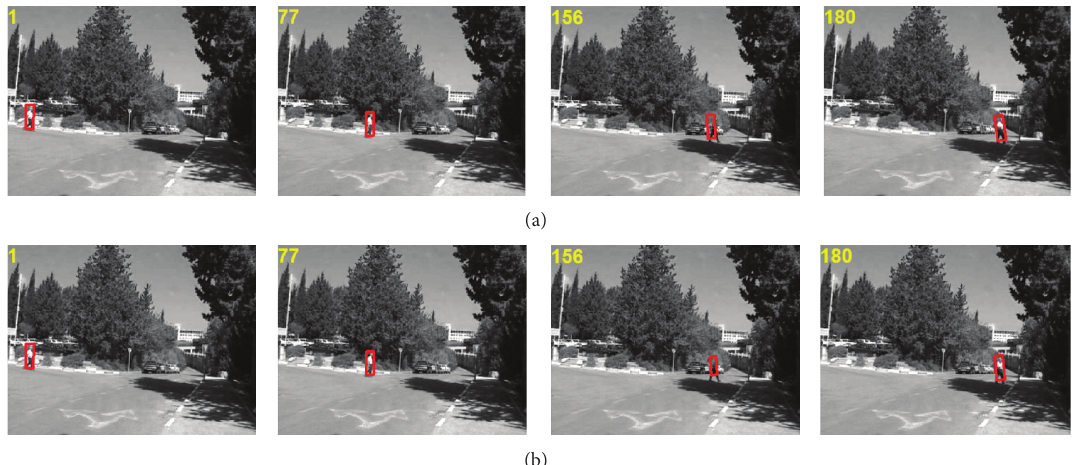
Figure 6: Tracking results for seq.2. The first row: results for IVT. The second row: results for our method.